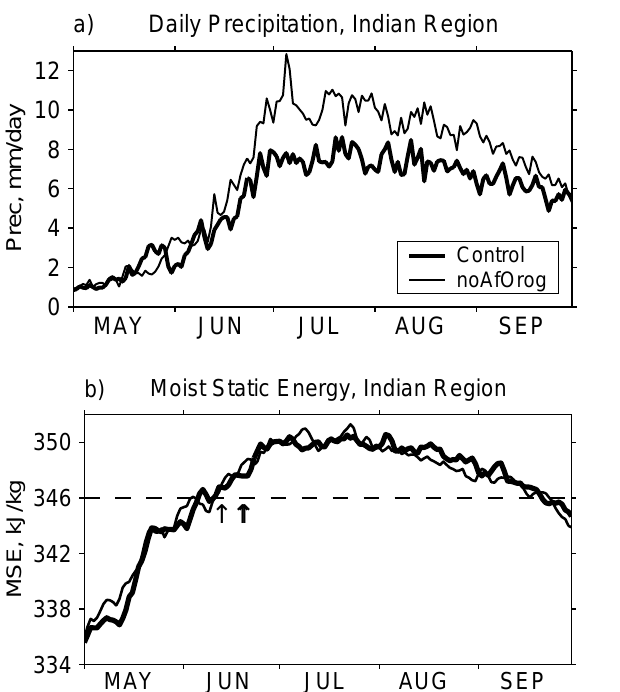
Fig. 14. Evolution of (a) precipitation and (b) moist static energy in control and noAfOrog simulations.